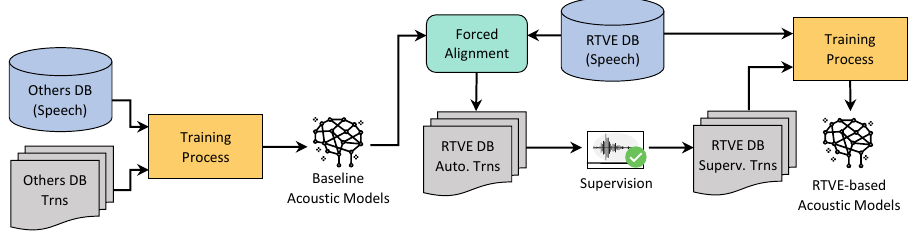
Figure 2. Entire process of obtaining high-quality transcriptions to train the acoustic